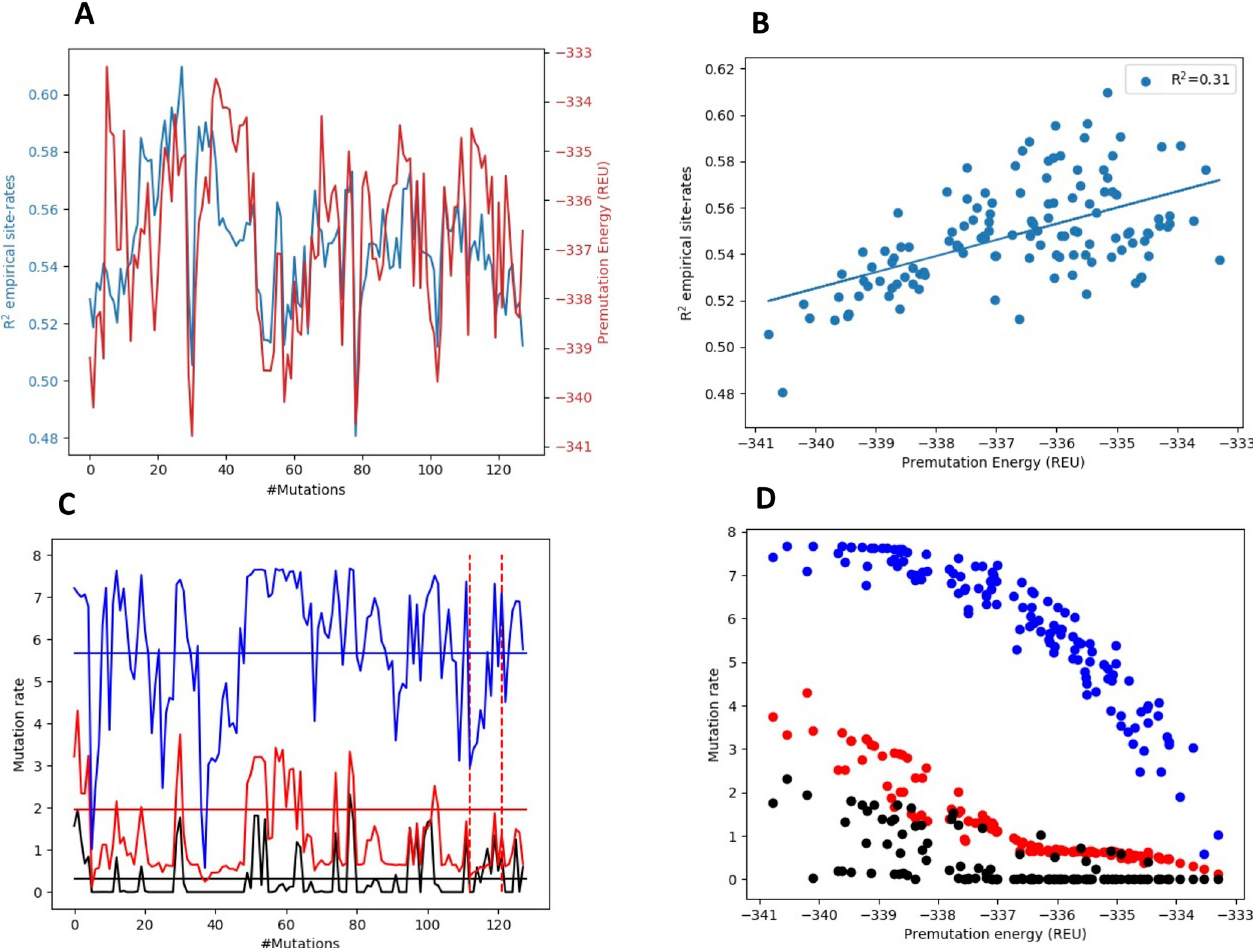
Fig 7. Fluctuation in substitution rates during a trajectory and correlations with stability. A) Correlation between calculated and empirical site-specific rates (calculated as R 2 -values) for azurin (blue) as a function of the number of introduced mutations. Fluctuation in energy as a function of introduced mutations (blue). B) Correlation between R 2 -values and energies are shown in A). Selection pressure in trajectory is set to -322. C) Site-specific rates for the sites in azurin. Residue 41 (blue), residue 49 (green) and residue 66 (red). Empirical site rates from rate4site as solid lines and dashed lines show mutational events at the site. D) Dependence of site-rates in C) with premutation stability. Energies in Rosetta Energy Units